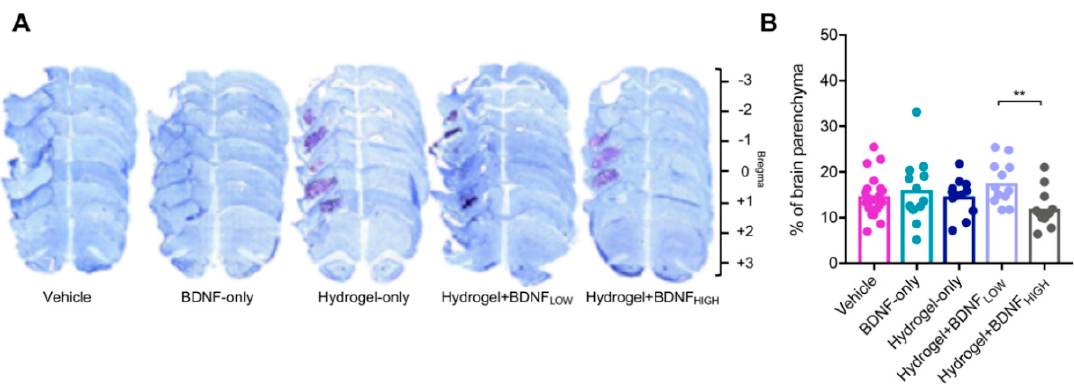
Figure 3. Effects of BDNF and delivery vehicle on infarct volume. ( A ) Representative photomicrographs of sections stained with cresyl violet at 5 × magnification. Purple-stained hydrogel are observable in the stroke cavities of hydrogel-only, hydrogel + BDNF LOW and hydrogel + BDNF HIGH groups. ( B ) Quantification of infarct volume. Infarct volume is reduced in rats treated with hydrogel